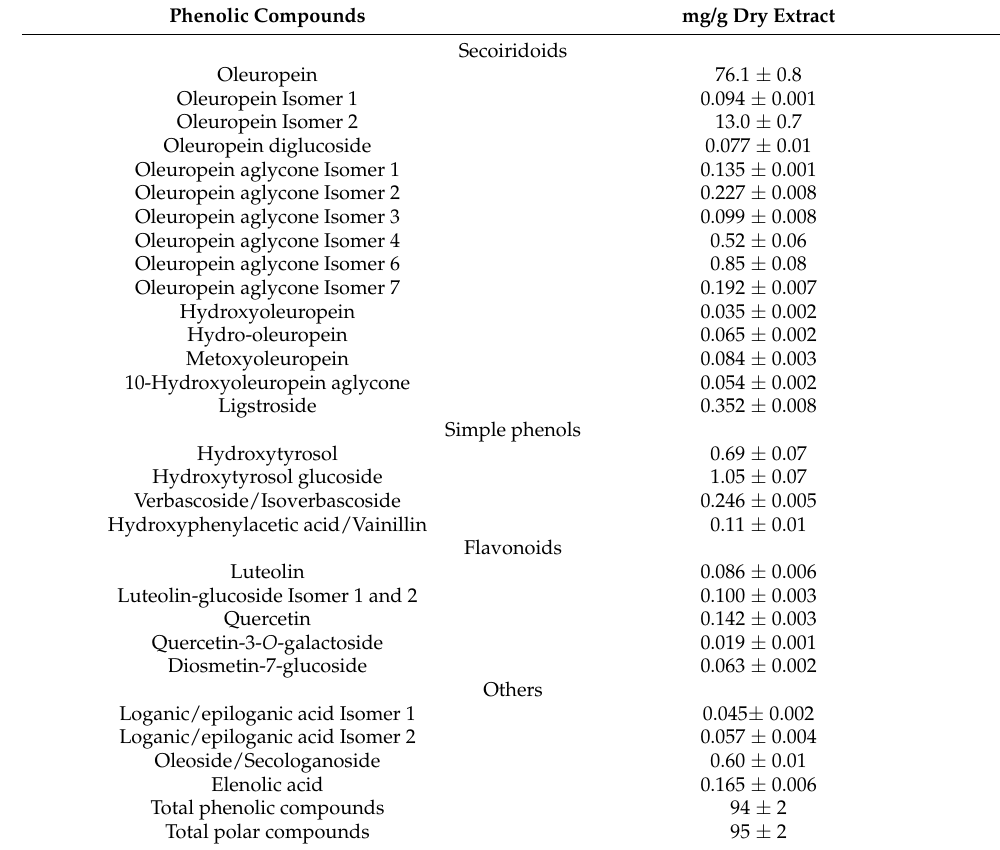
Table 2. Quantification of selected compounds from olive leaf